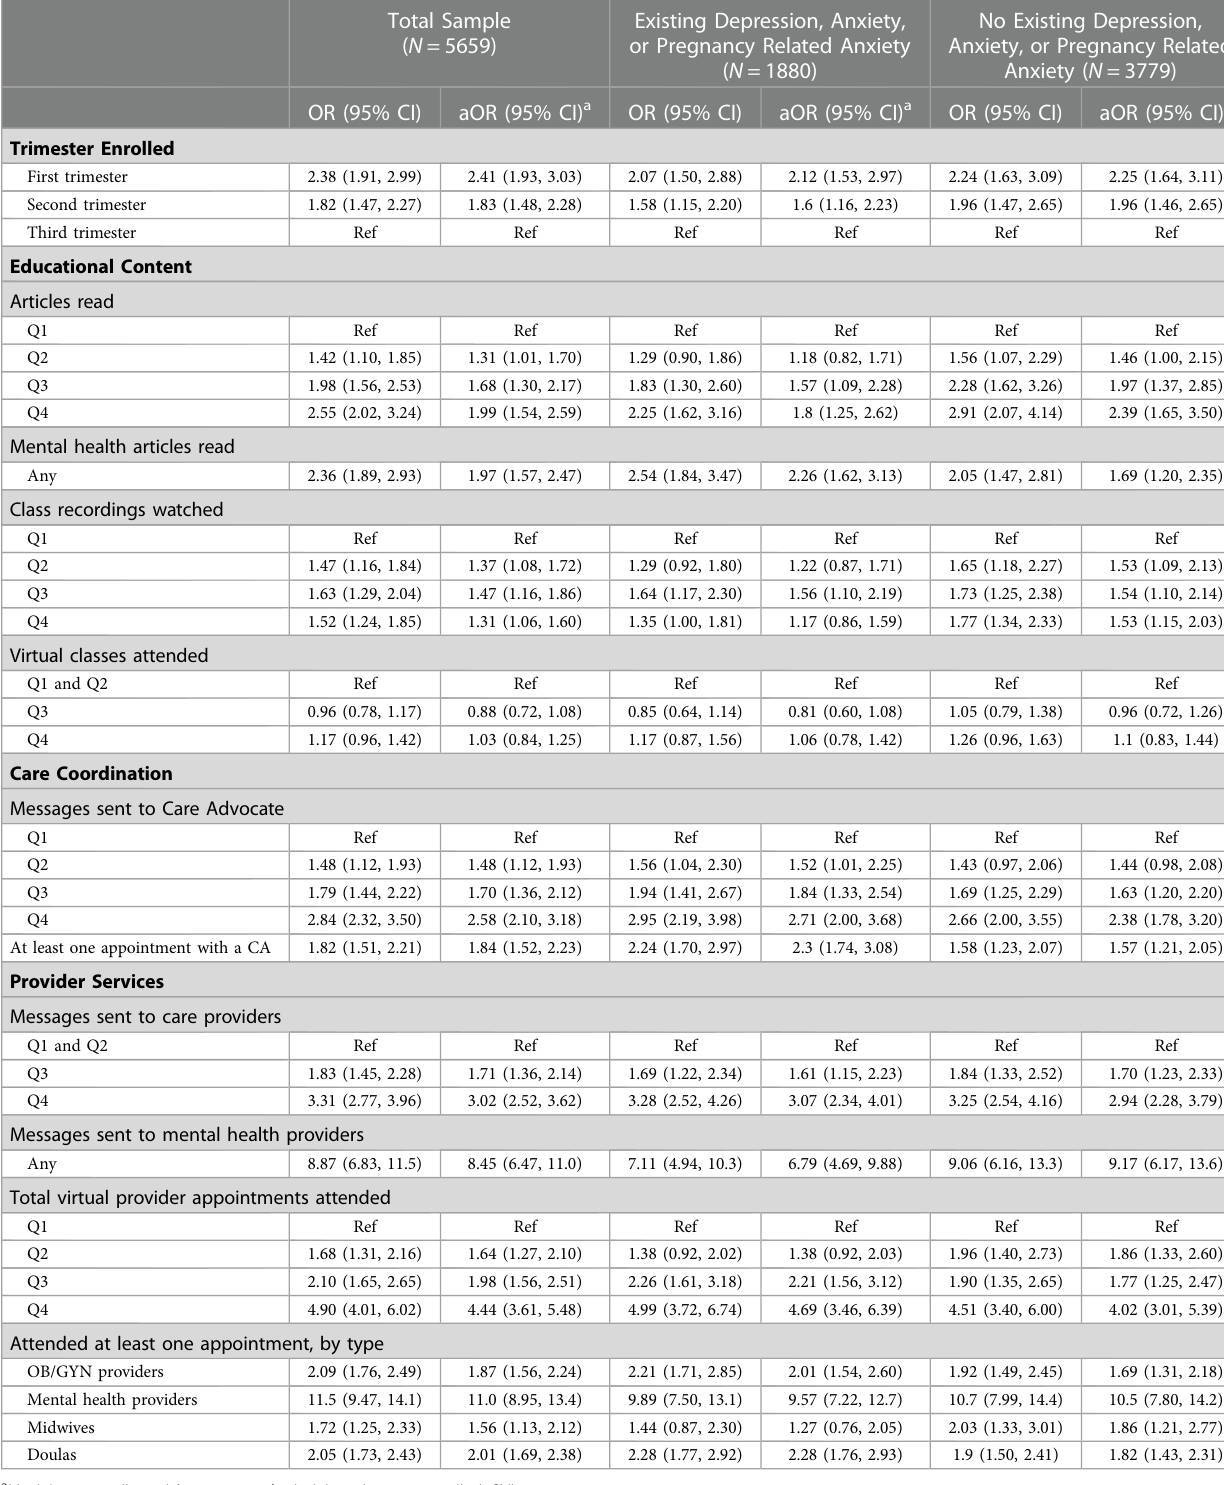
Total Sample Existing Depression, Anxiety, No Existing Depression, ( N = 5659) or Pregnancy Related Anxiety Anxiety, or Pregnancy Related ( N = 1880) Anxiety ( N =